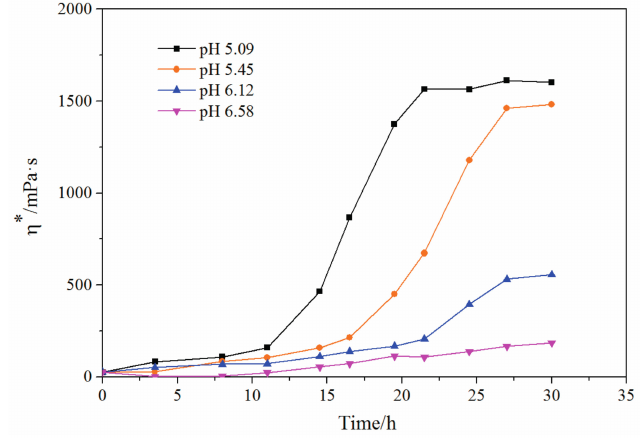
Figure 11. Effect of pH on the crosslinking reaction process of the polymer gel.